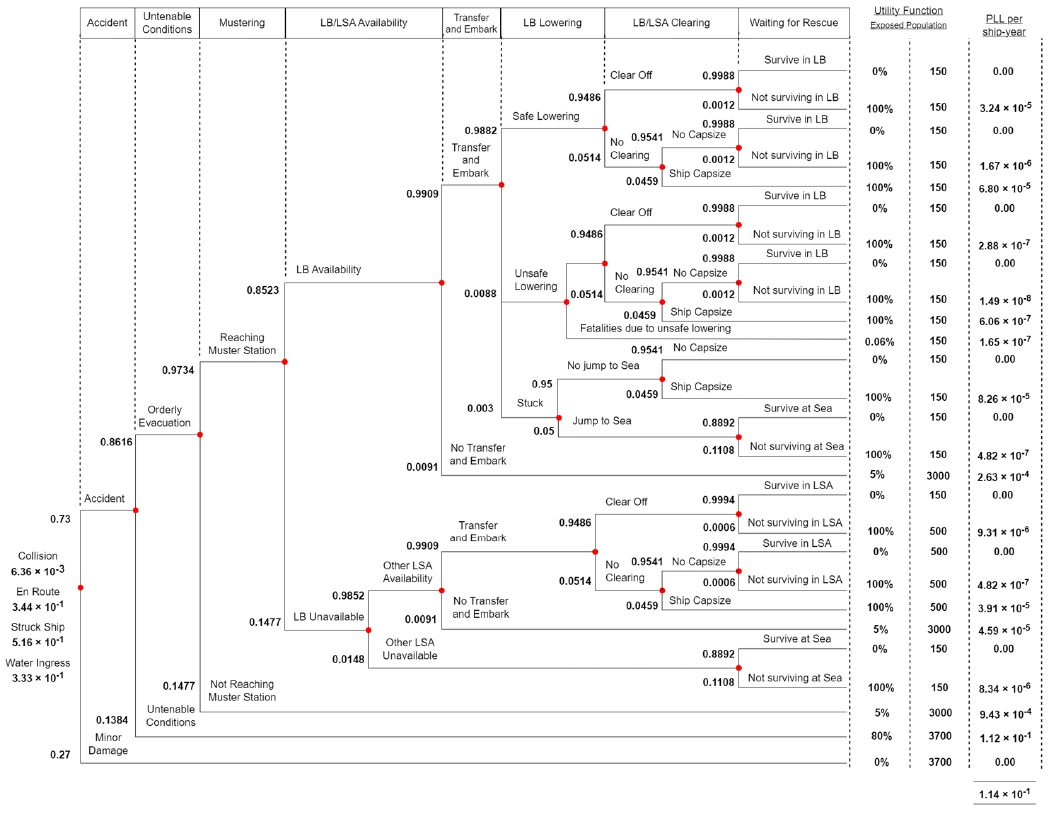
Figure 10. Event tree calculations and results for the baseline scenario of collision accidents.